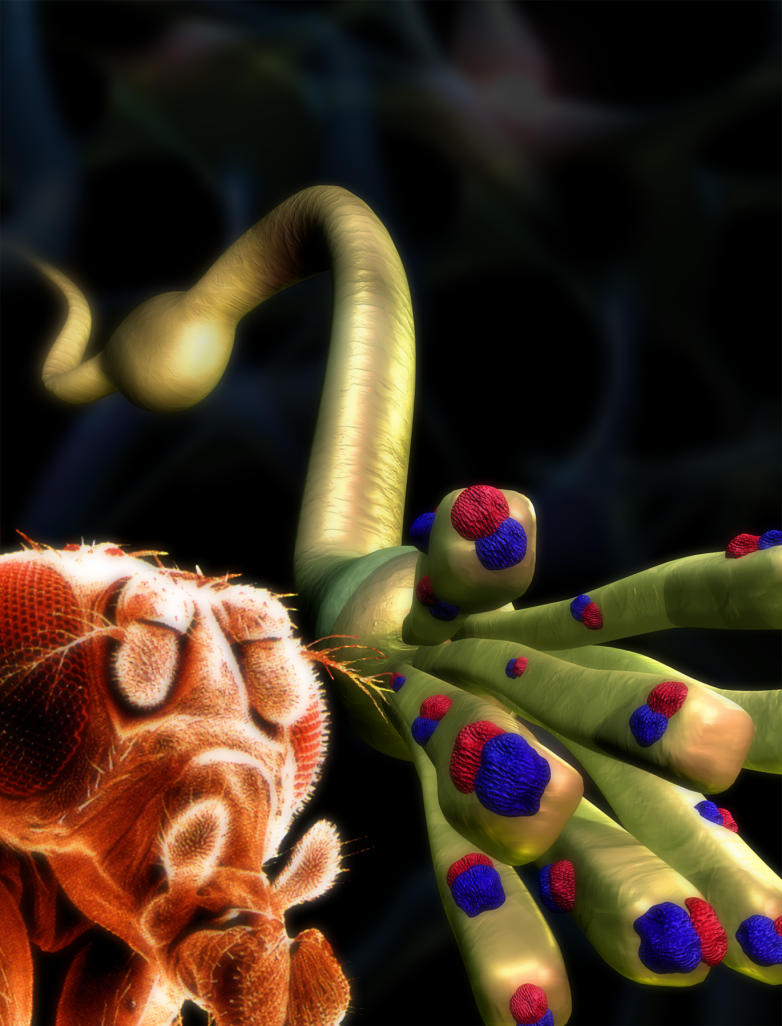
Olfactory receptors localized to the cilia of sensory neurons in
Drosophila